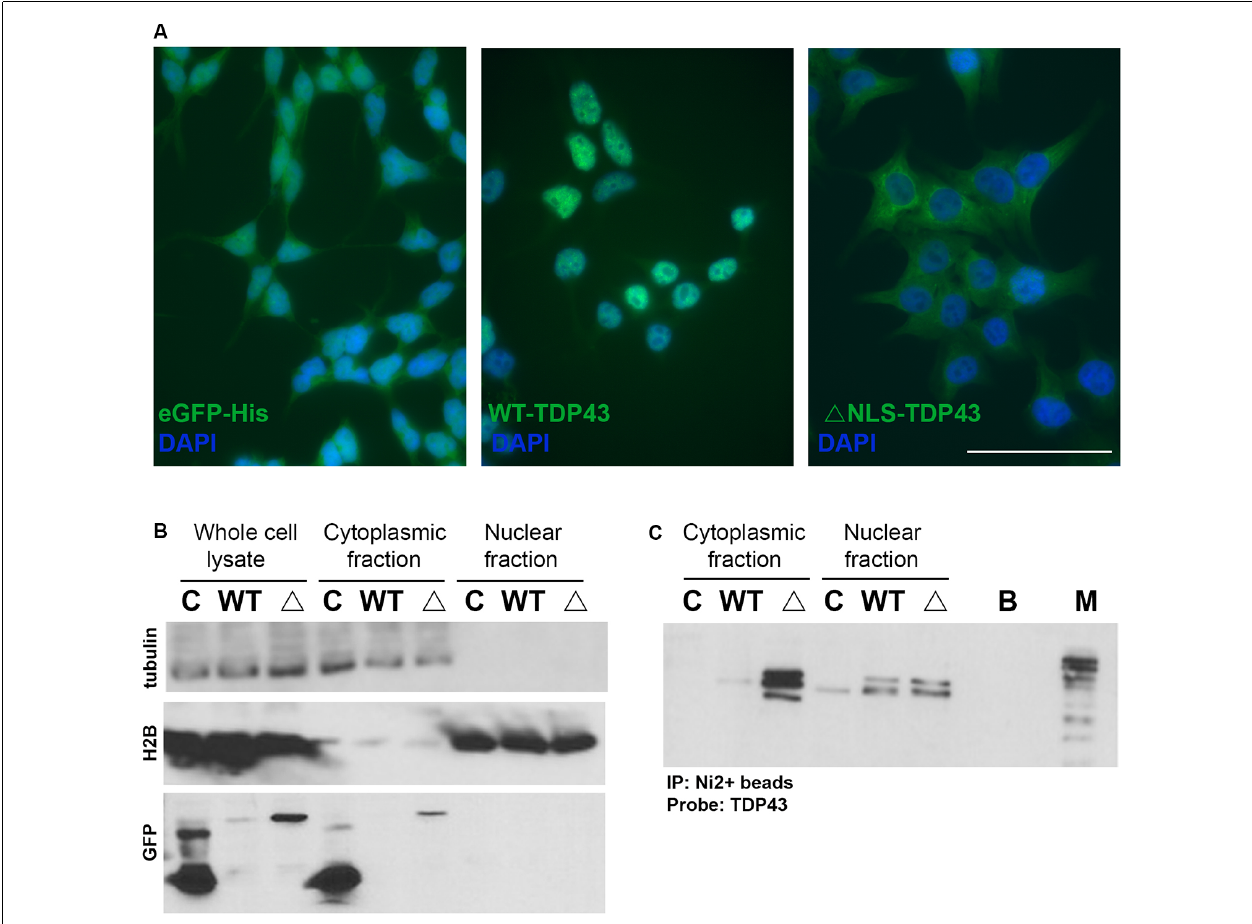
FIGURE 2 | Doxycycline-inducible stable cell lines expressing TDP43 variants. (A) Representative images of control (eGFP-His), wild-type (WT)-TDP43-eGFP-His (WT-TDP43), and ∆ NLS-TDP43-eGFP-His ( ∆ NLS-TDP43) stable HeLa cell lines depict primarily nuclear expression for WT-TDP43 and predominantly cytoplasmic expression for ∆ NLS-TDP43. Scale bar = 50 µ m. (B) Immunoblotting of whole-cell lysates and cytoplasmic and nuclear fractions for α -tubulin (cytoplasmic marker; top panel), H2B (nuclear marker; middle panel), and eGFP (a marker for expression of the eGFP-His-tagged doxycycline-inducible plasmids) following subcellular fractionation of the control (C), WT-TDP43-eGFP-His (WT), and ∆ NLS-TDP43-eGFP-His ( ∆ ) lines. eGFP immunoblotting demonstrates that eGFP-His (lower band) is expressed in the whole-cell lysates and cytoplasmic fraction of the control cell line, while eGFP-His-tagged TDP43 (upper band) is present in the whole-cell lysates and cytoplasmic fraction of the WT-TDP43-eGFP-His and ∆ NLS-TDP43-eGFP-His cell lines, although only marginal expression seen in the WT-TDP43-eGFP-His cell line. (C) TDP43 immunoblotting following pull-down of the His-tagged proteins using Ni 2+ beads. ∆ NLS-TDP43-eGFP-His is detected mainly in the cytoplasmic fraction, with some expression also seen in the nuclear fraction, while WT-TDP43-eGFP-His is more highly abundant in the nuclear fraction, though modest expression is also seen in the cytoplasmic fraction. The slightly higher bands in both TDP43 lines represent the TDP43-eGFP-His fusion proteins, while the lower bands represent endogenous TDP43. In the cytoplasmic fraction, ∆ NLS-TDP43-eGFP-His also exhibits a third band (lowest) that likely reflects a proteolytic cleavage product of TDP43. C = eGFP-His; WT = WT-TDP43-eGFP-His; ∆ = ∆ NLS-TDP43-eGFP-His; B = Ni 2+ bead only control; M =